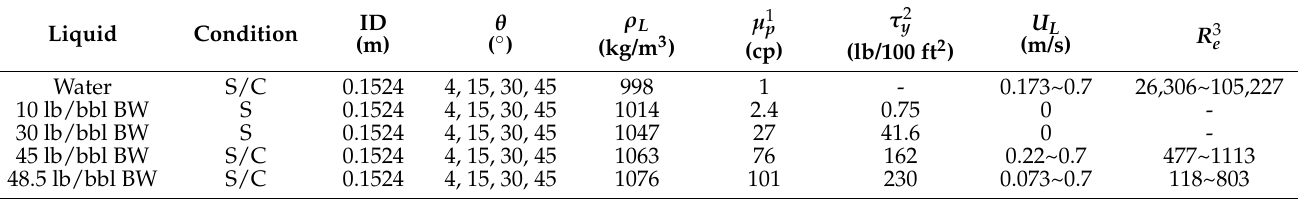
Table 1. Physical properties and test